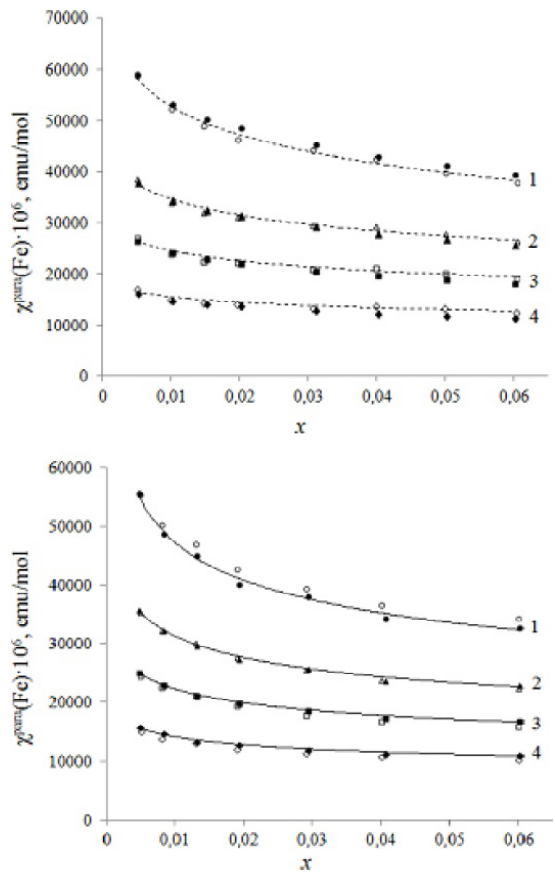
Fig. 8 . Comparison of experimental and calculated values of the paramagnetic component of magnetic susceptibility of the iron-containing solid solutions Bi BaNb Fe O (dotted lines) and Bi 2 2-2 x 2 x 9-  Fe O (solid lines) at 90K (1), 140K (2), 200K (3), 3x 15-  and 260K